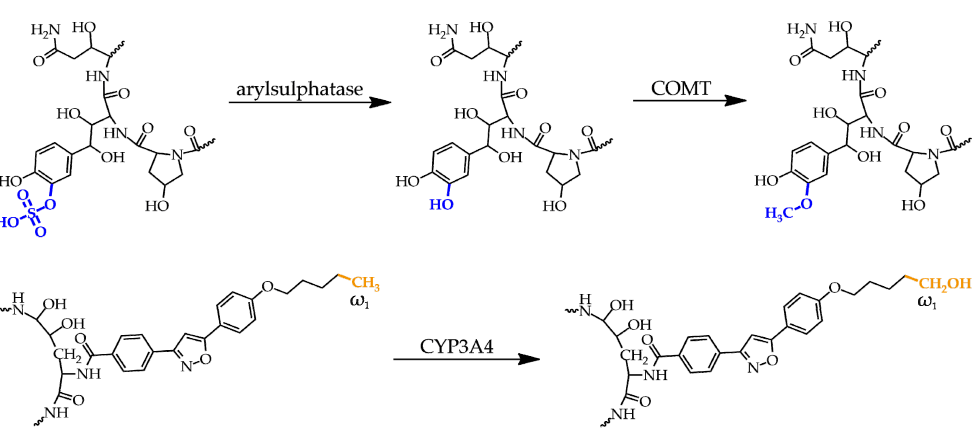
Figure 5. Metabolites of micafungin. Top: The original sulphate group (blue) on the dihydroxyhomotyrosine amino acid residue is metabolized to a hydroxyl group followed by its methylation. Bottom: the third and minor metabolite arises from hydroxylation of the methyl group (orange) at the ω 1 position of the lipophilic side chain. COMT = catechol- O -methyltransferase. Adequate antifungal dosing strategies are necessary for ensuring successful treatment. The optimal antifungal dosages vary by given patient populations and include both patient physical condition and type of treatment. Therefore, dosage recommendations are written in several guidelines and review articles, including aspergillosis and candidiasis in neonates [42], pediatrics [43], and adults [44,45]. These recommendations are summarized and simplified in Table 3.